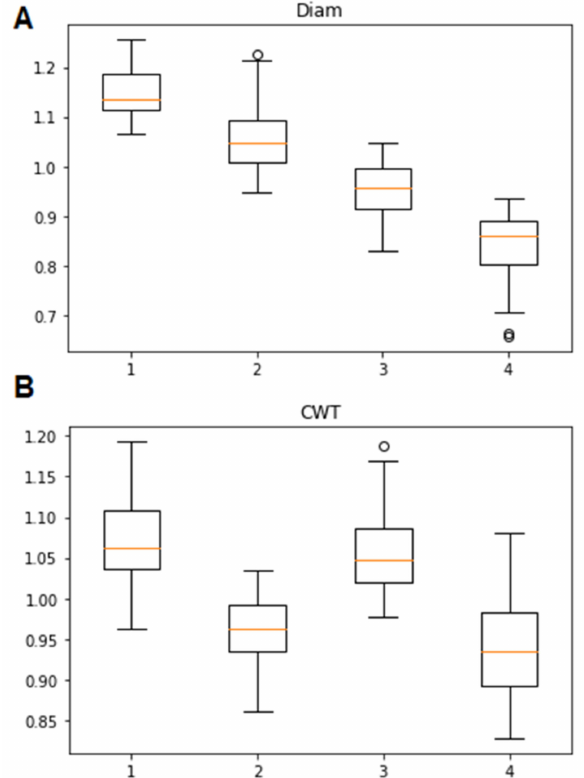
Figure 5. Box and Whisker plots for the cell radial diameter Diam ( A ) and cell wall thickness CWT ( B ) for four clusters: orange line—median; box—25% and 75% quartiles; whiskers—non-outlier minimum and maximum; circle—outlier (See the details in